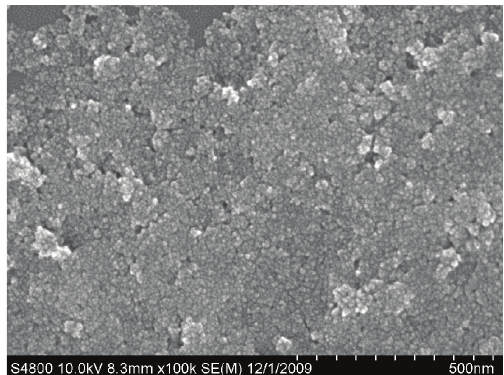
Figure 3: SEM micrograph of as-synthesized 10mol% La 2 O 3 doped CeO 2 .